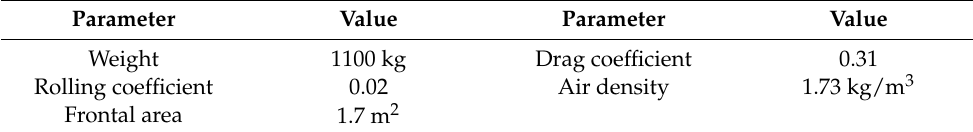
Table 5. Mechanical properties of